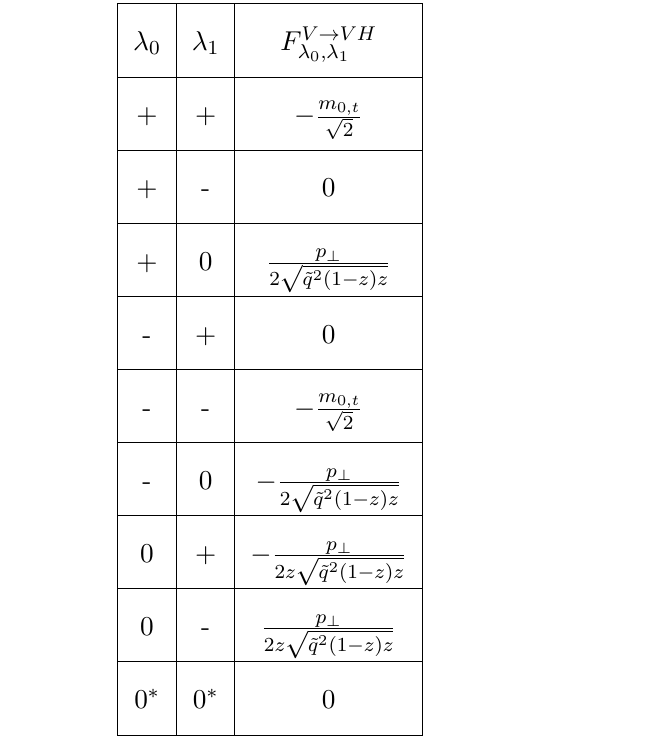
Table 4. Spin-unaveraged splitting functions for V → V H . In addition to the factors given above, each term has a phase e i ( λ 0 − λ 1 − λ 2 ) φ 0 , where λ 0 , 1 = ± , 0 represent the helicity states of the incoming and the outgoing guage vector bosons. The longitudinal polarization states which are marked as λ 2 = 0 ∗ give the relevant components in Dawson’s approach [54] and can be used to eliminate singularities that appear in the p ⊥ (cid:29) m i , i = 0 , 2